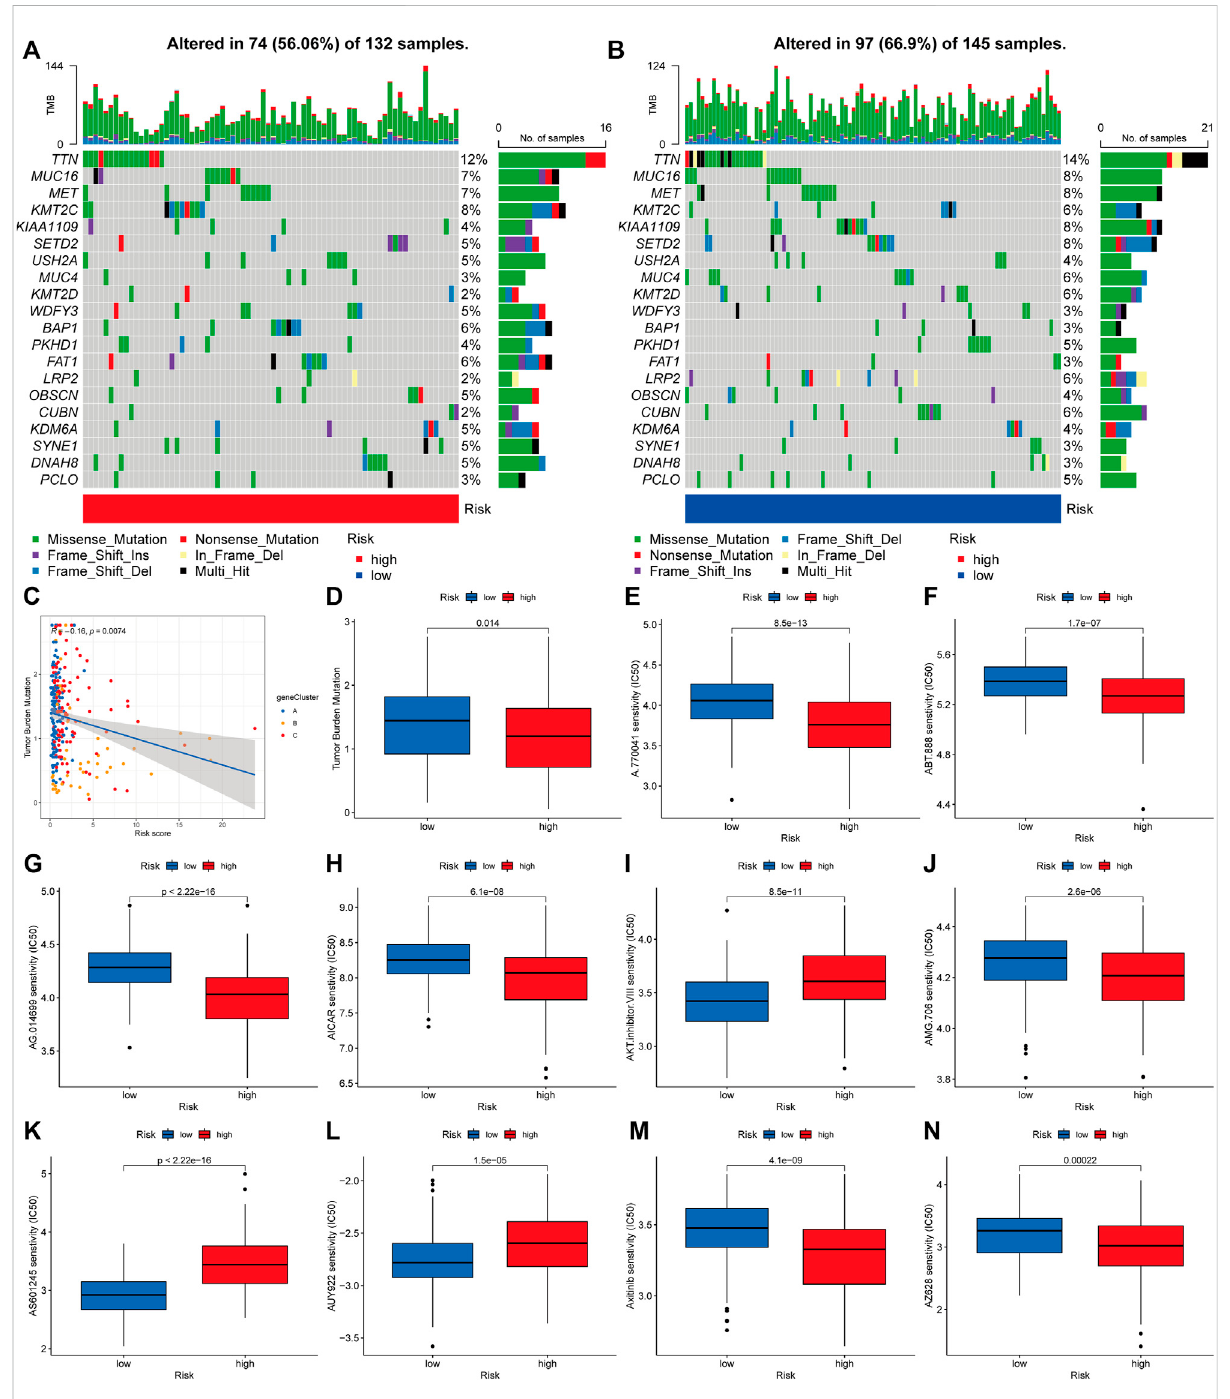
FIGURE 9 Analyzing genetic mutations and drug susceptibility. (A,B) The waterfall plot depicting the somatic mutation characteristics associated with various risk scores. The numbers on the graph show the frequency of mutation. The fraction of mutation types is shown by the box on the right. (C) Spearmancorrelationstudyofriskscoreandtumormutationalburden.Rrepresentsthecorrelationcoef fi cient,andwhenitisnegative,itmeansthat thetumor burdenmutation is negatively correlated with therisk score. (D) Tumor mutational burden in several risk score categories. (E – N) The relationship between risk score and drug sensitivity. Red represents the high-risk group and blue represents the low-risk group. The lower the half maximal inhibitory concentration (IC50) value, the more sensitive the group of patients to the